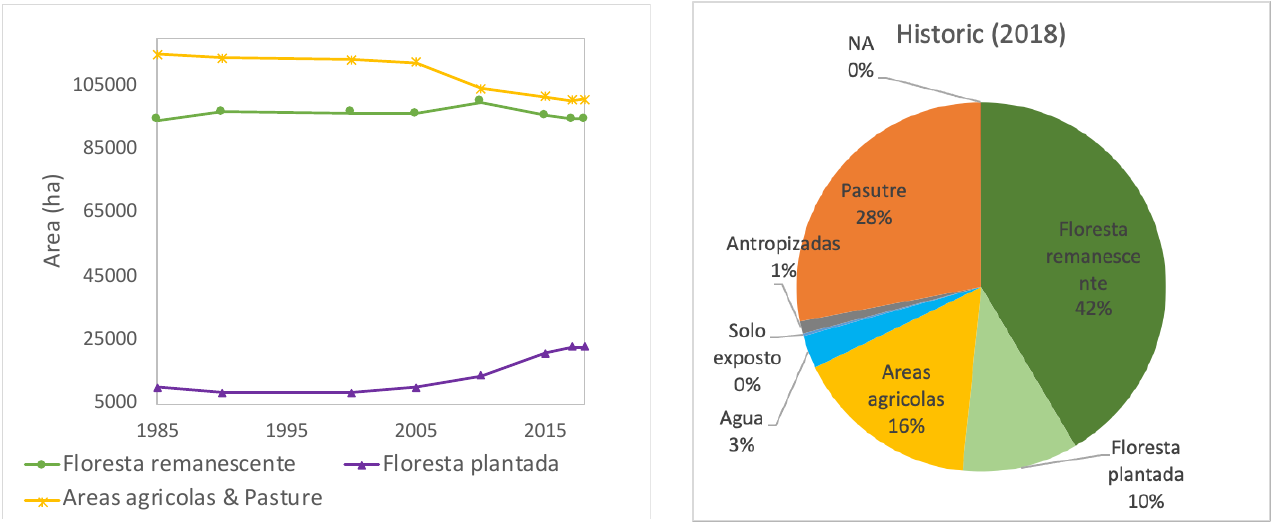
Figure A1. Historic land-use/land-cover (LULC) changes and the most recent distribution across the Cantareira Water Supply System.